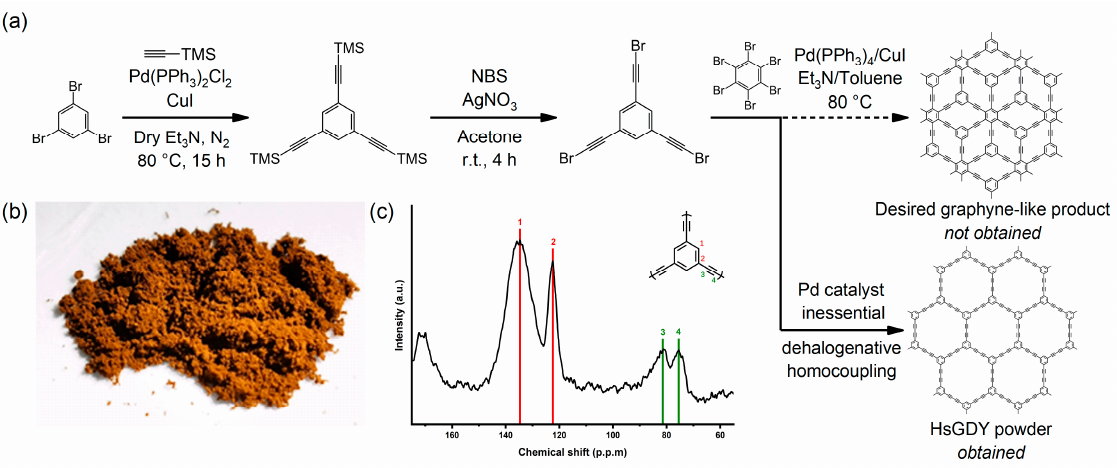
Figure 1. ( a ) Synthesis of HsGDY powder. ( b ) A photograph of HsGDY powder. ( c ) The 13 C solid-state NMR spectrum of HsGDY